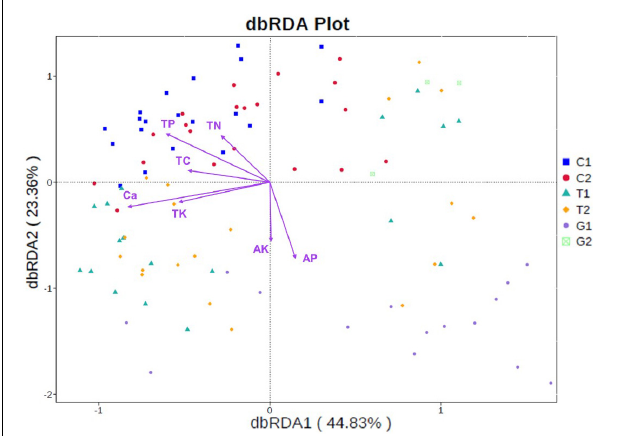
FIGURE 6 | Distance-based redundancy analysis (db-RDA) of soil physicochemical properties with microbial community at phylum level. C1: cultivated land with distance to river from 100 to 200 m; C2: cultivated land with distance to river from 300 to 500 m; G1: grassland with distance to river from 100 to 200 m; G2: grassland with distance to river from 300 to 500 m; T1: forestland with distance to river from 100 to 200 m; T2: forestland with distance to river from 300 to 500